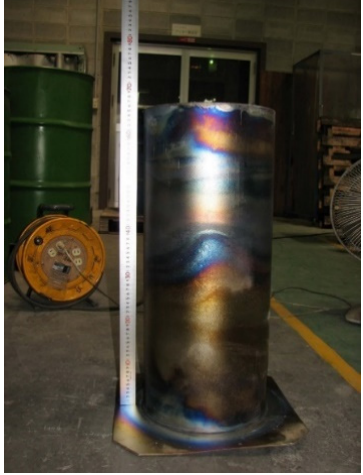
Figure 8. Appearance of the large Ti-42Al-5Mn ingot. Table 1. Compositions of Ti-42Al-5Mn ingots produced by Y 2 O 3 crucible melting and skull melting in wt%.